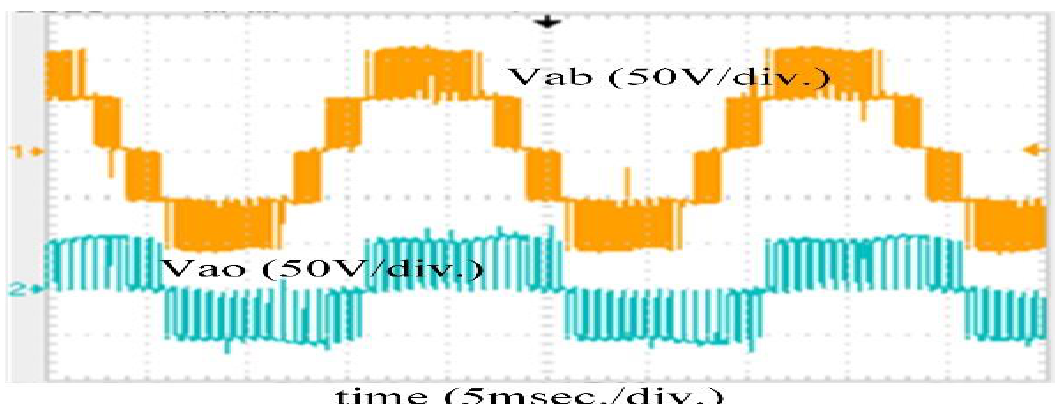
Figure 16. Experimental waveforms at M=1 and input voltage Vdc_1 = Vdc_2= 50 volt. line voltage (𝑉 𝑎𝑏 ) and pole voltage (𝑉 𝑎𝑜 = 𝑉 𝑎𝑁 ) .